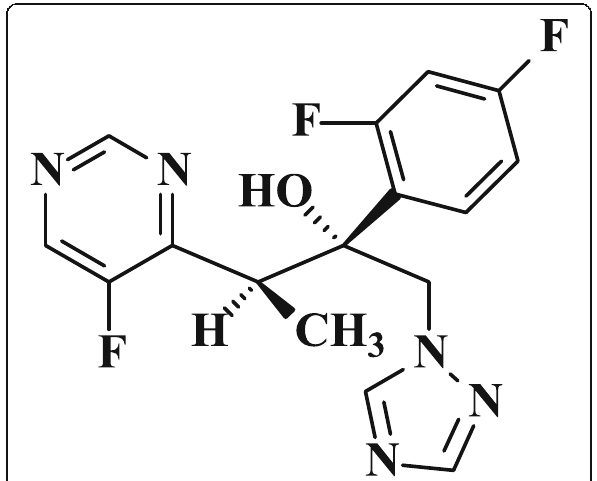
Fig. 1 Chemical structure of voriconazole